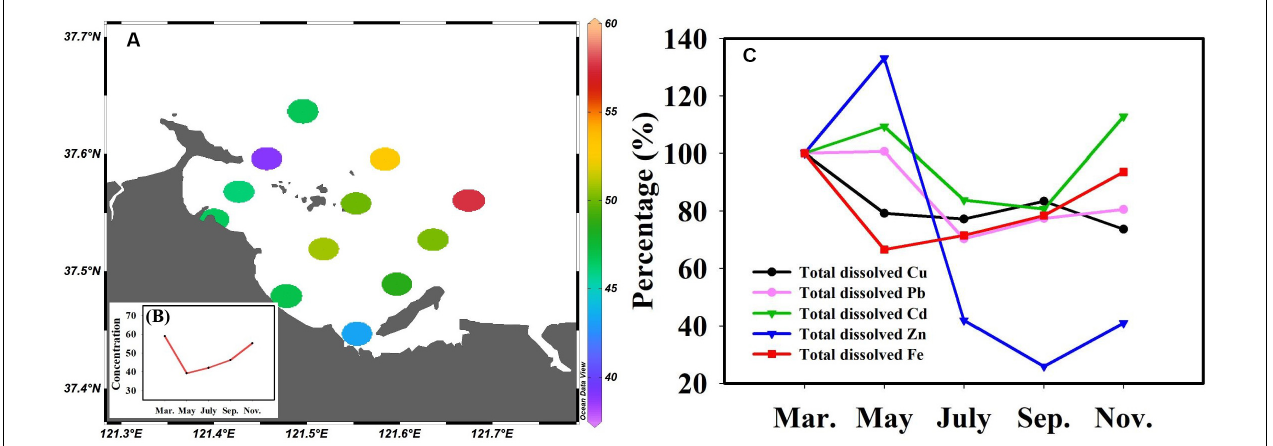
FIGURE 8 | Spatial-temporal distribution of total dissolved Fe concentrations in surface seawater of Sishili Bay and the change trend of Cu, Pb, Cd, Zn, and Fe. (A) Spatial distribution (nmol/L, annual average values), (B) temporal variation (nmol/L, monthly average values). (C) Change trend of Cu, Pb, Cd, Zn, and Fe. Percentage values indicate the change trend of the metal concentrations in other months compared with the first months (where the first month’s concentration is equal to 100%).